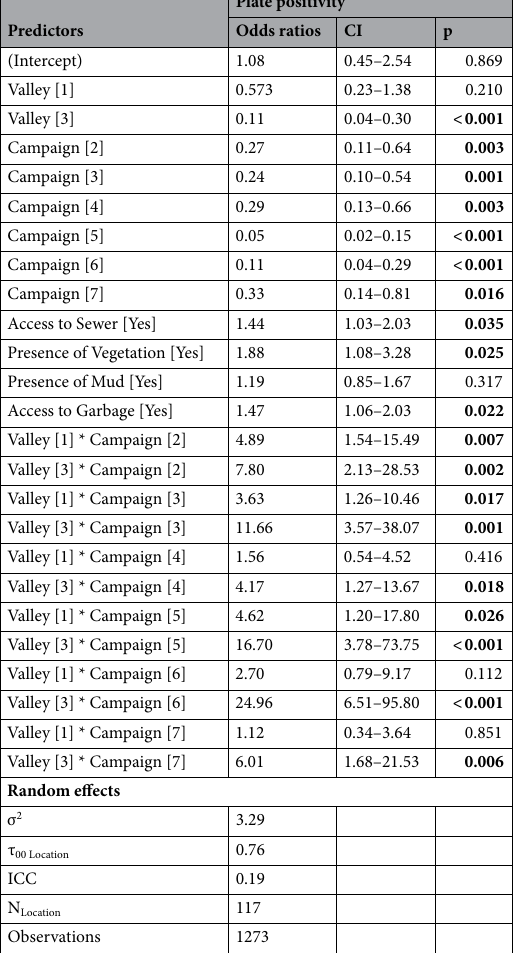
Table 1. Summary of the generalized linear mixed-effects model with rodent infestation associated variables, and the interaction between valley and campaign to determine the recovery rate of rodent infestation after the interventions. Significant values are in